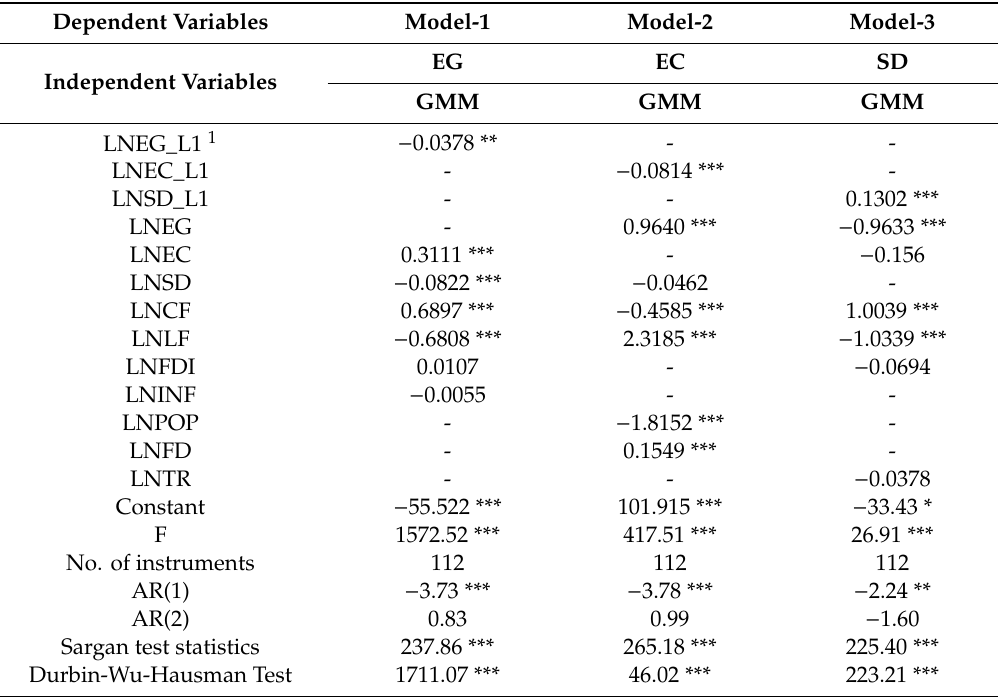
Table 4. Results of System-Generalized Method of Moment (GMM).